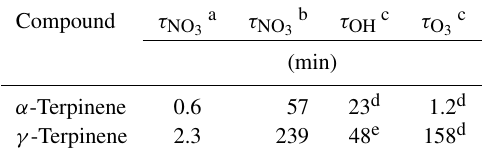
Table 6. Atmospheric lifetimes of α - and γ -terpinene with respect to their oxidation by NO 3 and OH radicals and by